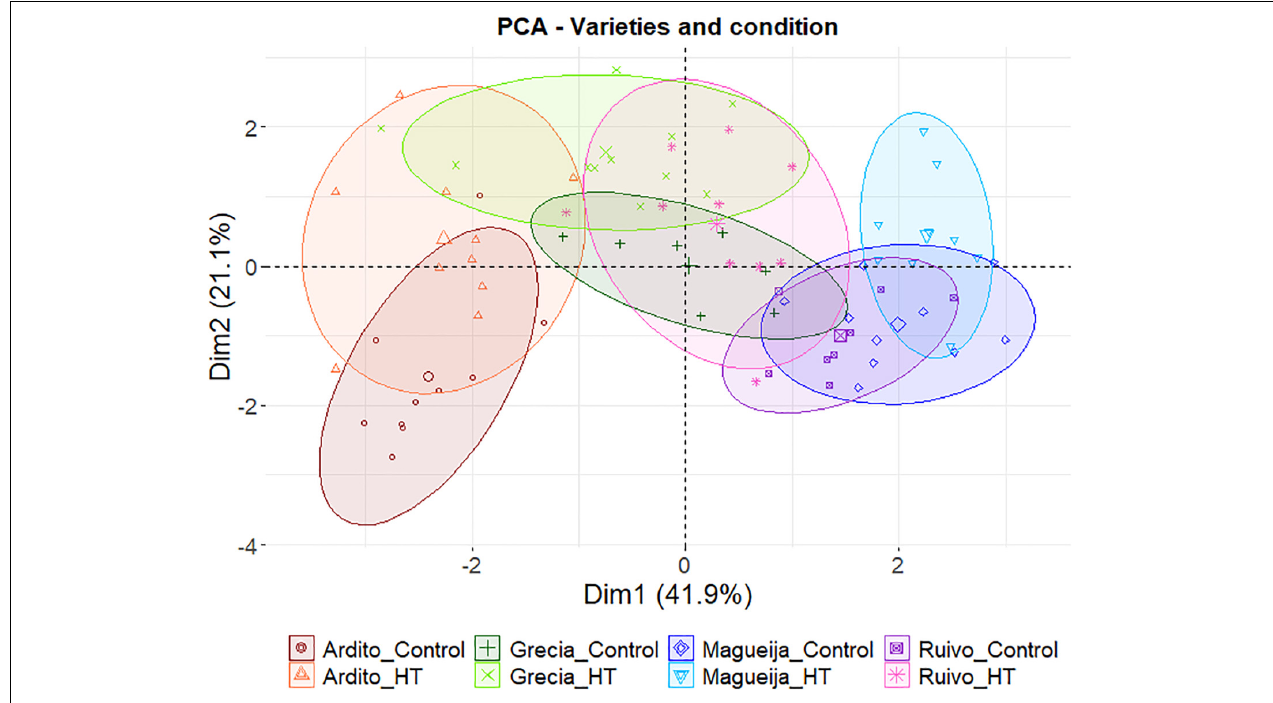
FIGURE 6 | Principal component analysis using yield parameters (plant height and area, number of spikes, first spike length, and grains number and weight) and grain protein content of Ardito (red), Grécia (green), Magueija (blue), and Ruivo (pink) plants kept in control conditions (darker colors) or HT treated (lighter